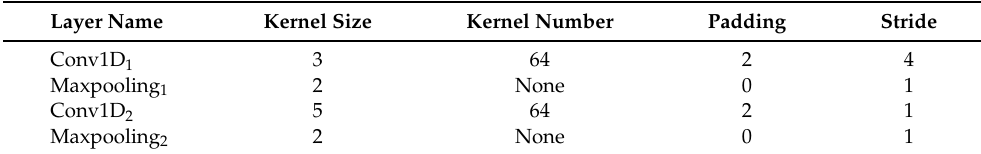
Table 3. Characteristics of the selected datasets used to evaluate deep learning models in this work.